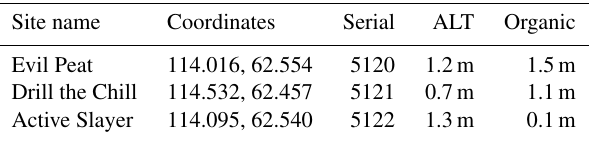
Table 1. Sites details, including coordinates (west, north), serial numbers of instruments, active layer thickness (ALT) and the ap- proximate thickness of the organic layer overlying mineral